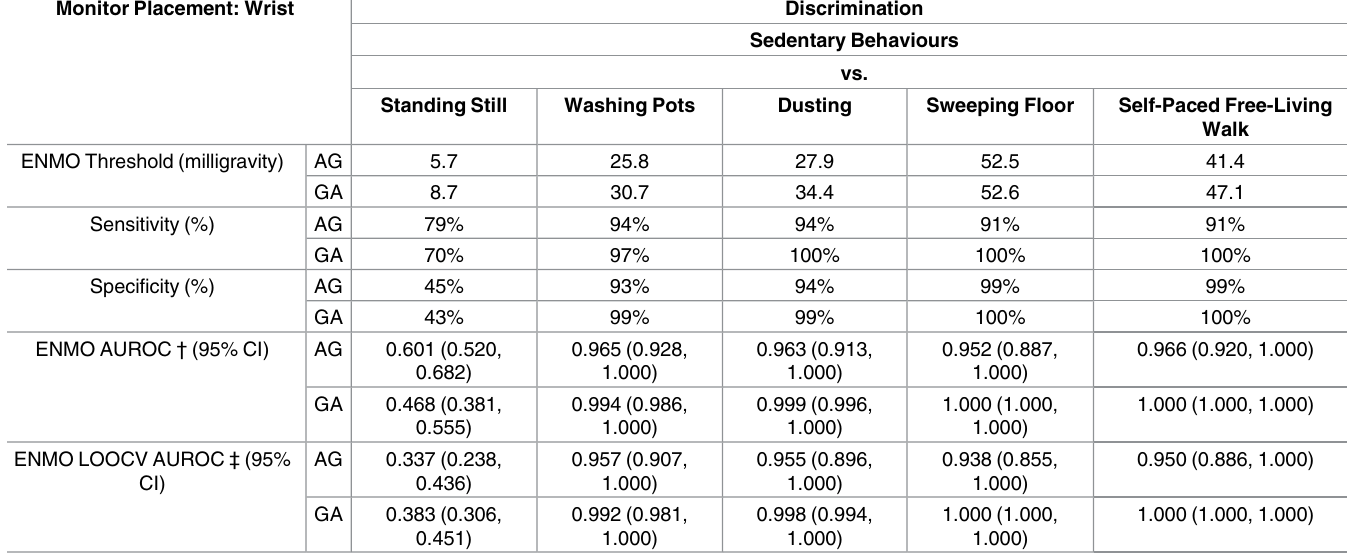
Table 5. Monitor-specific wrist Euclidean Norm Minus One (ENMO (measuredin milligravity units)) thresholds to differentiate between sedentary behaviours and light-intensity physical activities. Monitor Placement: